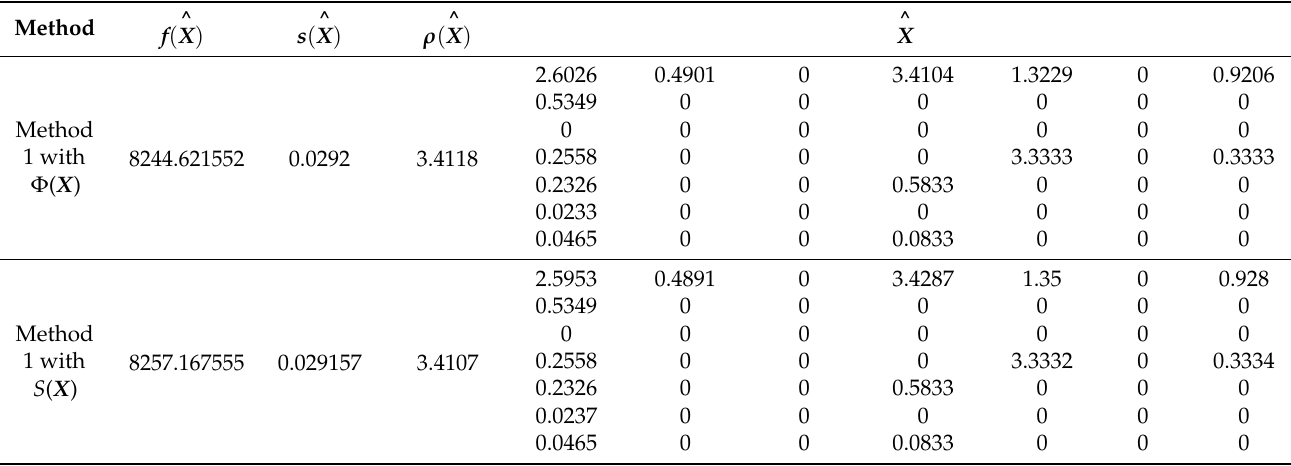
Table 6. Results for Example